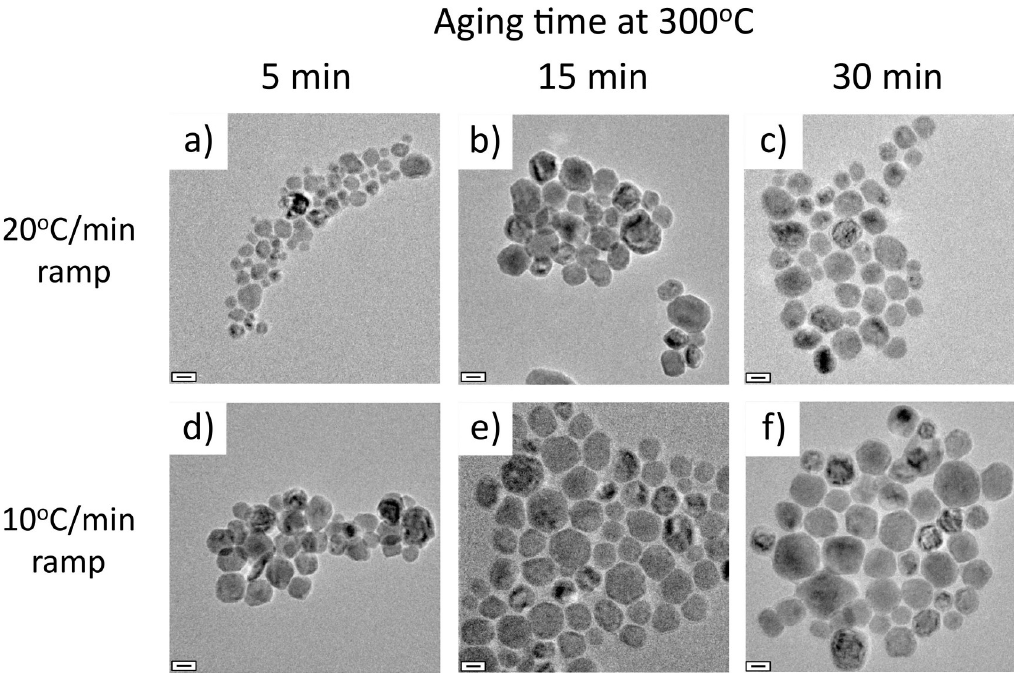
Fig 2. TEM images of MnO NPs generated from each of the 6 different temperature profiles: 20˚C/min ramp with a) 5 min at 300˚C, b) 15 min at 300˚C, c) 30 min at 300˚C, and 10˚C/min ramp with d) 5 min at 300˚C, e) 15 min at 300˚C, and f) 30 min at 300˚C. The MnO NPs have a rounded octagon shape, but some variation in size. Scale bars are 20 nm.